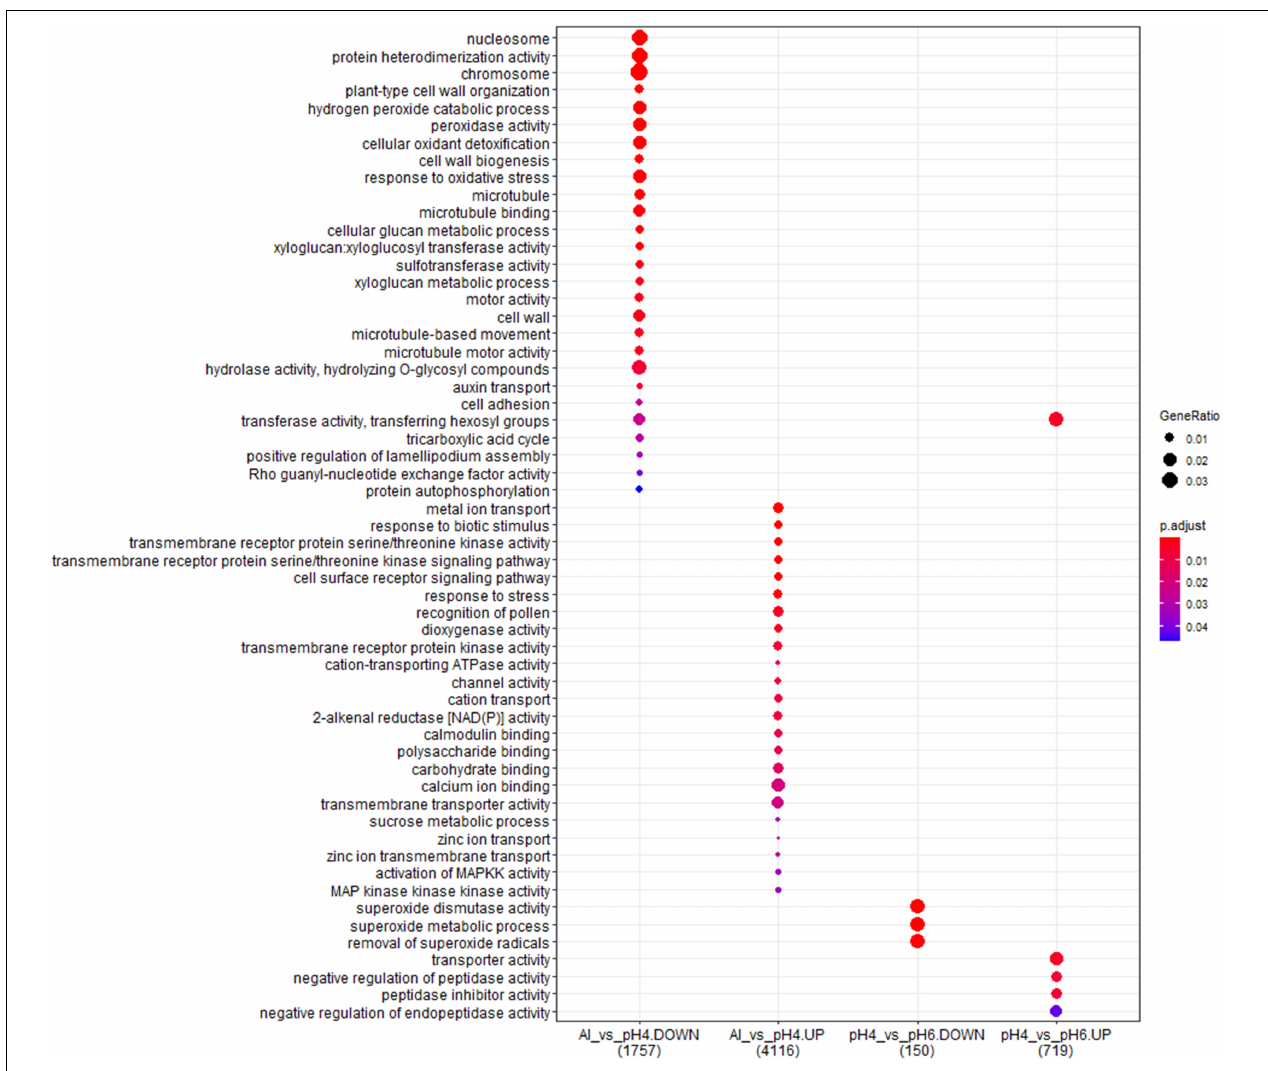
FIGURE 13 | The comparison of GO terms over-representation analysis of differentially expressed genes in the long-term experiment using hypergeometric test under α = 0.05 with FDR adjusted P